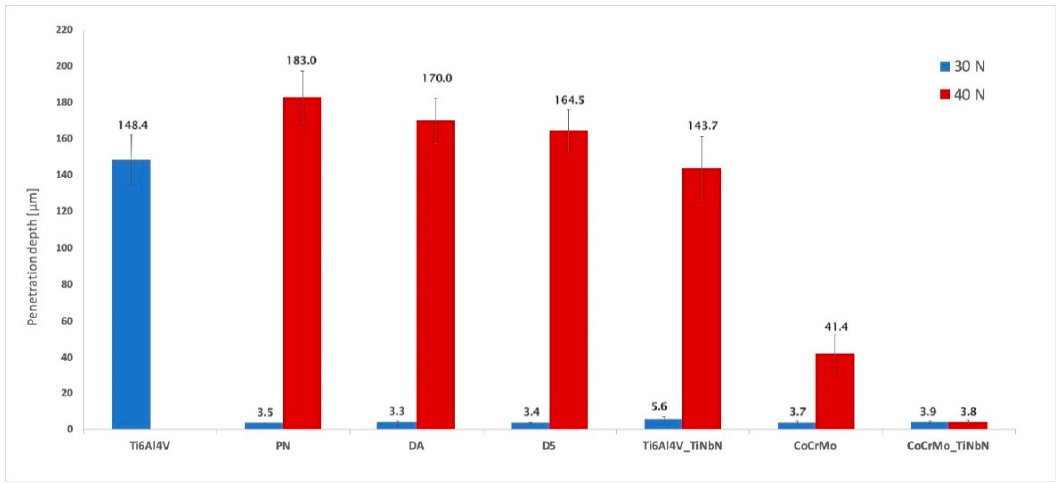
Figure 13. Wear depth values measured under normal loads of 30 and 40 N on the best-performing PEO layers and on the reference materials (uncoated or PVD (Ti,Nb)N coated Ti-6Al-4V and CoCrMo).